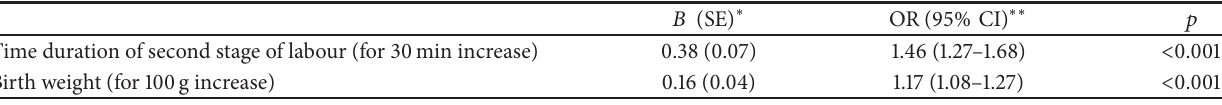
Table 4: Results from stepwisemultivariable logistic regression analysis with thedependentvariable presentedrouteof birth (vaginaldelivery ( 𝑁 = 888 ) versus CS delivery ( 𝑁 = 158